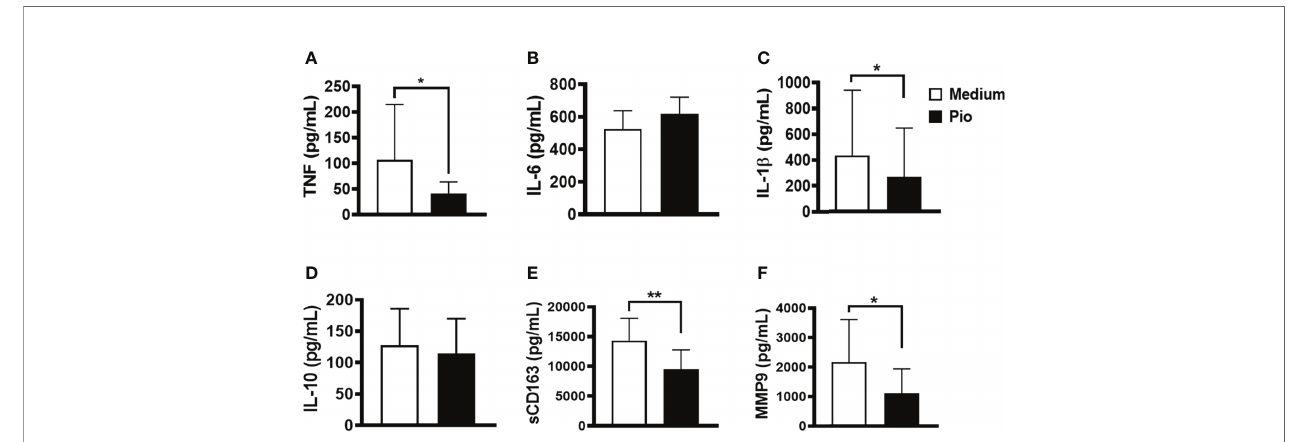
FIGURE 7 | Pioglitazone down-regulates the production of in fl ammatory mediators in cells from CL lesions. Biopsies from CL patients (n=10) and HS (n= 5) were obtained with a 4mm punch and cultured for 24 hours. The levels of (A) TNF, (B) IL-6, (C) IL-1 b , (D) IL-10, (E) sCD163 and (F) MMP9 were quanti fi ed by the ELISA technique. The box represents the mean and the line above the box the standard deviation. Statistical analyses were performed using the Paired t test *P